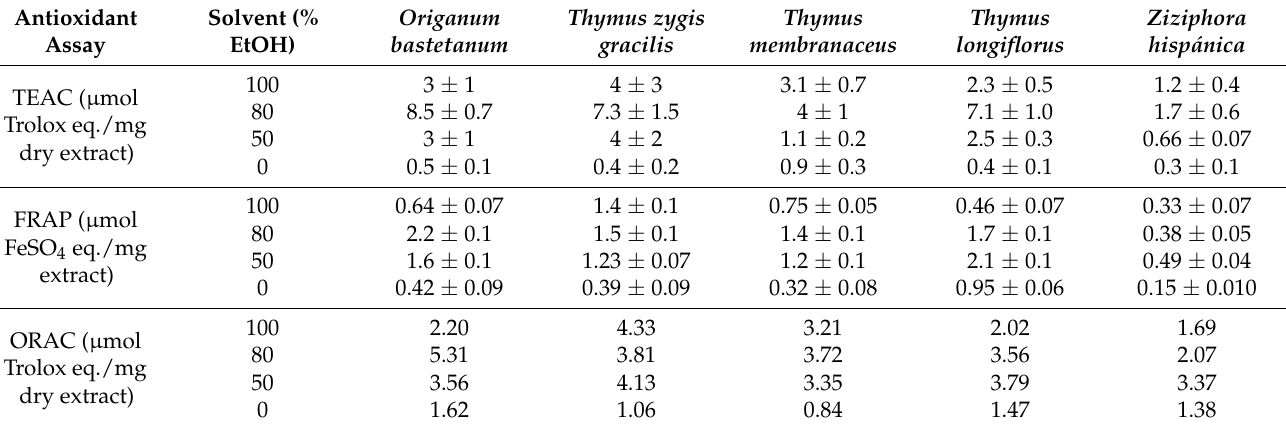
Table 2. In vitro antioxidant activity of extracts of aromatic plants obtained with different hy- droethanolic mixtures determined by FRAP, TEAC and ORAC